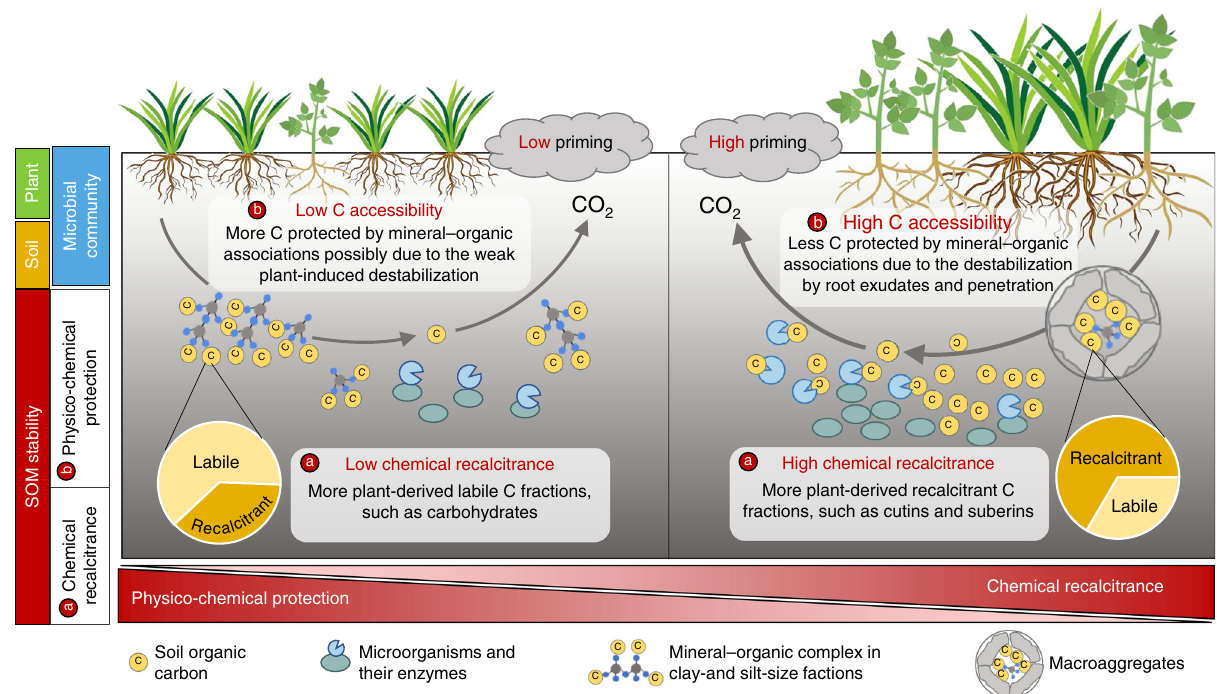
Fig. 5 Soil organic matter stability, as regulated by plant C input and community composition, determines the priming effect. With the increase of plant productivity and forb cover, more plant-derived recalcitrant SOM fractions (e.g. cutins and suberins) accumulated in the soil. The proportion of C occluded in macroaggregates increased at the expense of C associated with microaggregates and clay + silt fractions, and the physico-chemical protection by aggregations and minerals became weaken. Consequently, either ( a ) the increased chemical recalcitrance or ( b ) the reduced physico-chemical protection (increased C accessibility) could lead to the stronger priming intensity. Notably, this conceptual diagram mainly focused on the most important direct (i.e. soil organic matter stability) and indirect factors (i.e. plant properties) derived from the structural equation modelling productivity and a high soil C content. The soil orders in this region include Cambisol, Calcisol, Chernozem, and Kastanozem according to the World Refer- ence Base for Soil Resources 50 . To cover these broad environmental gradients, we sampled 30 sites (including 18 steppe sites and 12 meadow sites) along an ~2200km grassland transect during the growing seasons (between early July and early September) in 2013 and 2014 (Supplementary Fig. 1; Supplementary Table 1). These sites were set throughout the geographical extent of alpine grasslands along the major road at intervals of a certain distance 49 , covering a wide range of climates (mean annual temperature: − 3.7 to 6.9°C, mean annual precipitation: 89 – 534 mm), plant productivity levels (NPP: 38 – 488g m − 2 yr -1 ), soil properties (organic C: 1.1 – 118g kg − 1 ; pH: 6.2 – 9.4; silt content: 5 – 52%; bulk density: 1.0 – 1.5g cm -3 ) and microbial properties (microbial biomass C: 23 – 1101 mg Ckg -1 ) across the plateau (Supplementary Fig. 10; Supplementary Data 1). Notably, the major considerations for selecting these sampling sites were based on the precipitation gradient, because precipitation induced regional variations in vegetation 48 and soil properties 51 across our study area, which further determined the pattern of soil microbial community 52 . Field sampling was conducted according to a standardized sampling method 49 . Brie fl y, at each site, we set up fi ve 1m ×1 m quadrats at the corners and the centre of a 10m ×10 m plot. For each quadrat, we estimated the mean coverage for each vascular species and then determined the ANPP by clipping the aboveground plants at ground level. Moreover, soil samples in the top 10cm were collected from three quadrats along a diagonal line in the 10 m× 10m plot. Considering the high cost of laboratory analyses, as done in previous studies 11,12 , three replicates were mixed as one composite sample for subsequent analyses. The bulk density samples were obtained using a standard container with a fi xed volume size of 100 cm 3 and oven-dried at 105°C to obtain their masses. The oven-dried soil mass and container volume were then used to quantify the bulk density. Glucose addition experiment and uncertainty analysis . We conducted an isotope-labelled glucose addition experiment including two substrate addition treatments (deionized water or 13 C-labelled glucose) to determine the priming effect. For each site, fresh soil samples (20 g dry weight) were incubated in triplicate at a fi xed soil moisture level (60% of the water holding capacity). Given that the soils varied substantially in terms of their moisture during the fi eld collection, fi xing the soil moisture to the same percentage of the water holding capacity facilitated the comparison of microbial processes among multiple sites 53 . Mean- while, the gravimetric water content during the laboratory incubation was closely